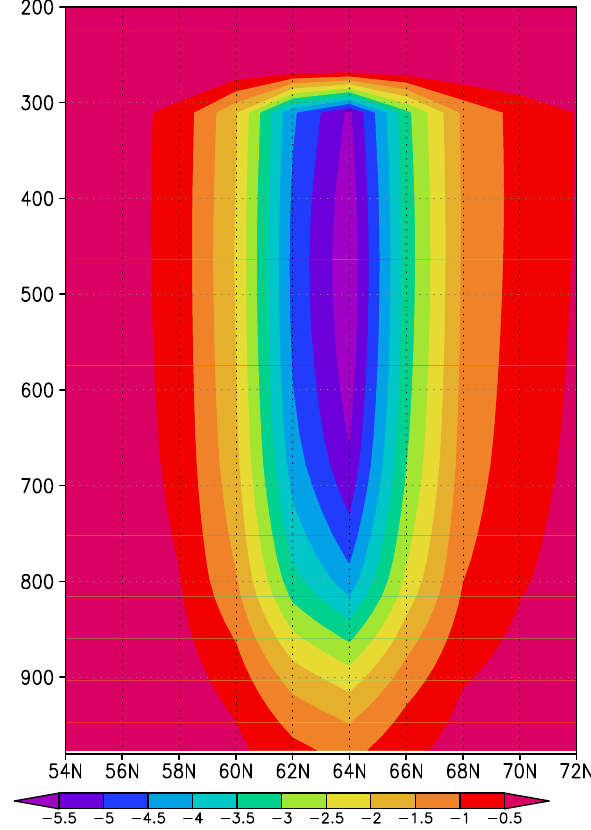
Fig. 3. The latitude-height structure of analysis increment for CO 2 Figure 3: The latitude-height structure of Analysis increment for CO 2 (ppm) computed in GEOS-5 (ppm) computed in GEOS-5 at 135 ◦ W, between 54 ◦ N and 72 ◦ N at 135 o W between 54 o N and 72 o N on July 1, 2006 at 135 o W. on 1 July